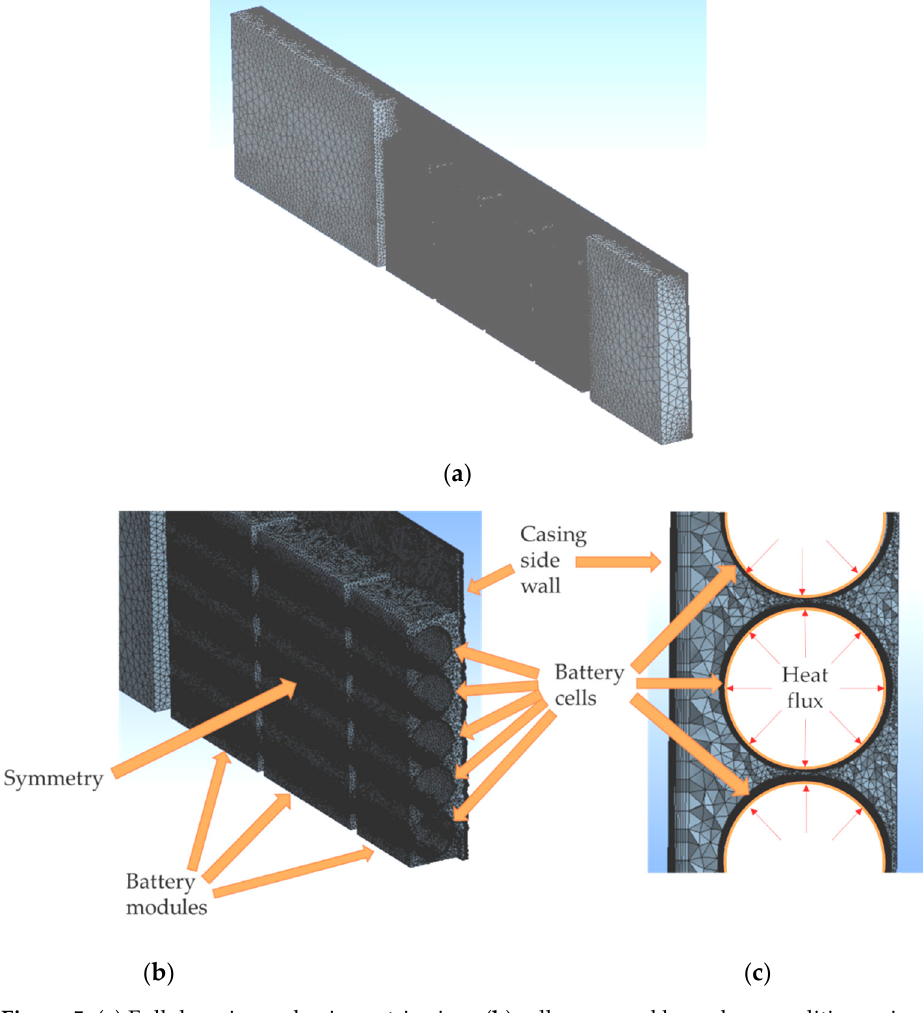
Figure 5. ( a ) Full domain mesh—isometric view; ( b ) cell zones and boundary conditions—isometric section view; ( c ) cell zone and boundary conditions—frontal section view.